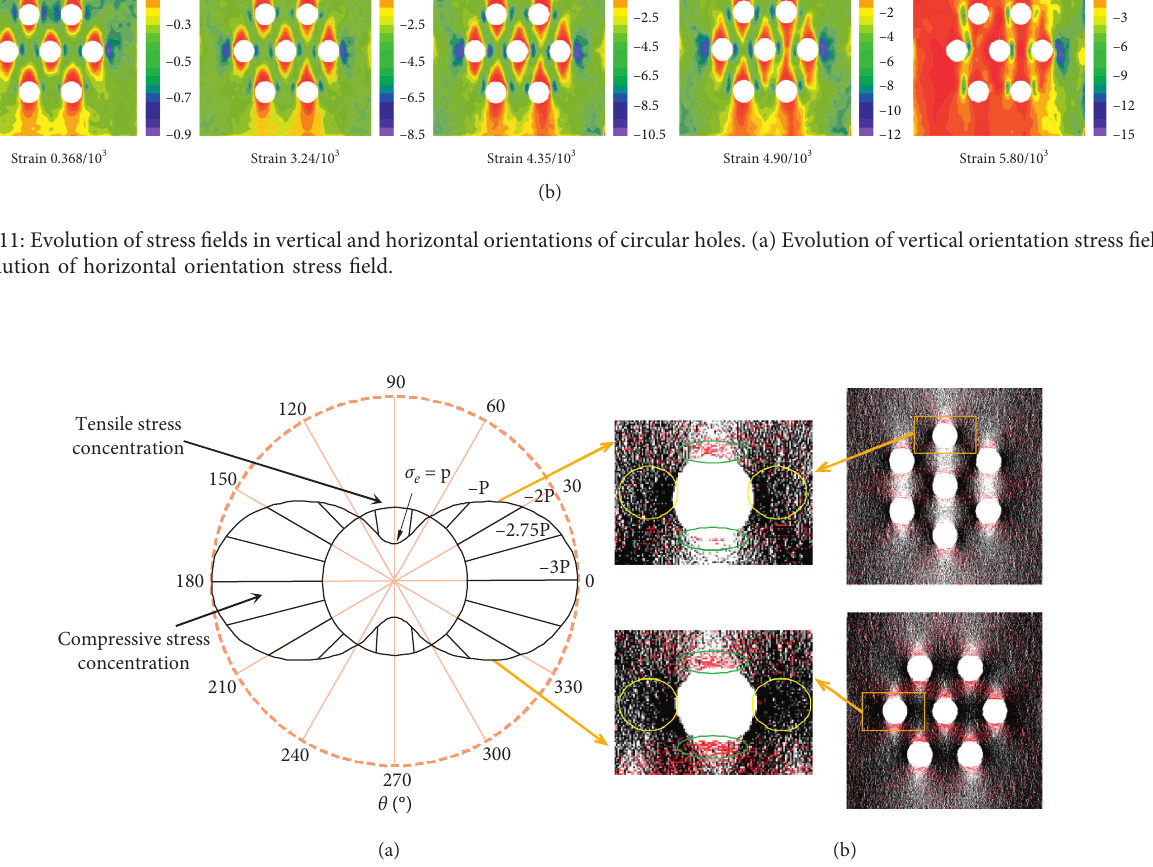
Figure 12: Distribution of tangential stress around a circular hole under uniaxial